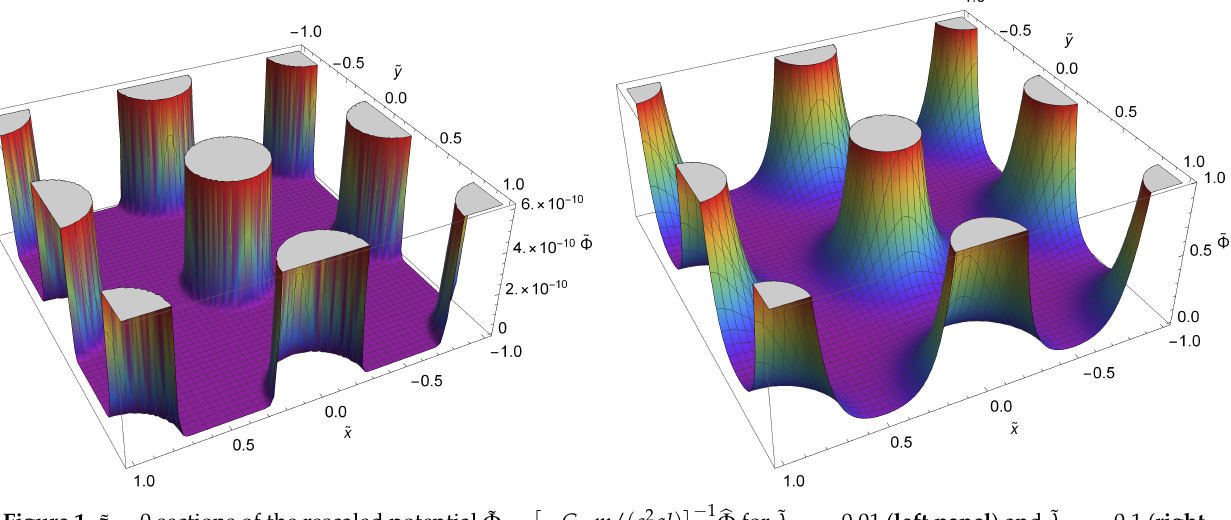
Figure 1. ˜ z = 0 sections of the rescaled potential ˜ Φ = panel ), respectively.